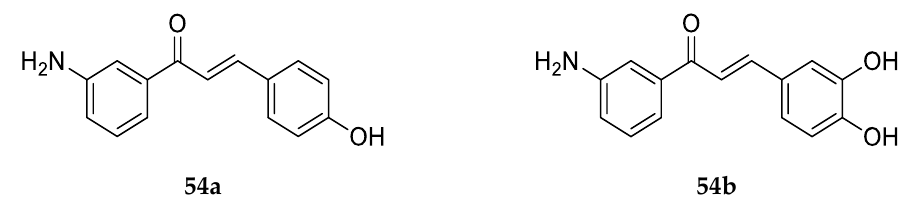
Figure 31. Chemical structures of 3-aminochalcone derivatives with substitution on ring B.